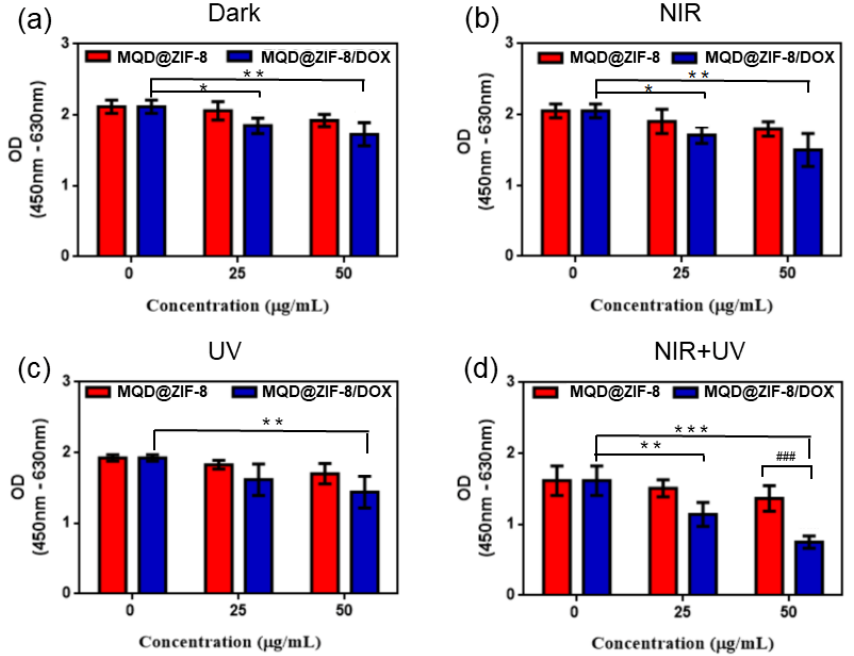
Figure 7. The OD value of HeLa cell with varied concentrations of MQD@ZIF-8 and MQD@ZIF- 8/DOX samples for 24 h ( a ) under dark condition; ( b ) under 808 nm NIR irradiation; ( c ) under UV light irradiation; ( d ) under 808 nm NIR +UV light irradiation. Error bars represented standard deviation from the mean ( n = 6). Asterisks indicated statistically significant differences (* p < 0.05, ** p < 0.01, ###, *** p < 0.001).